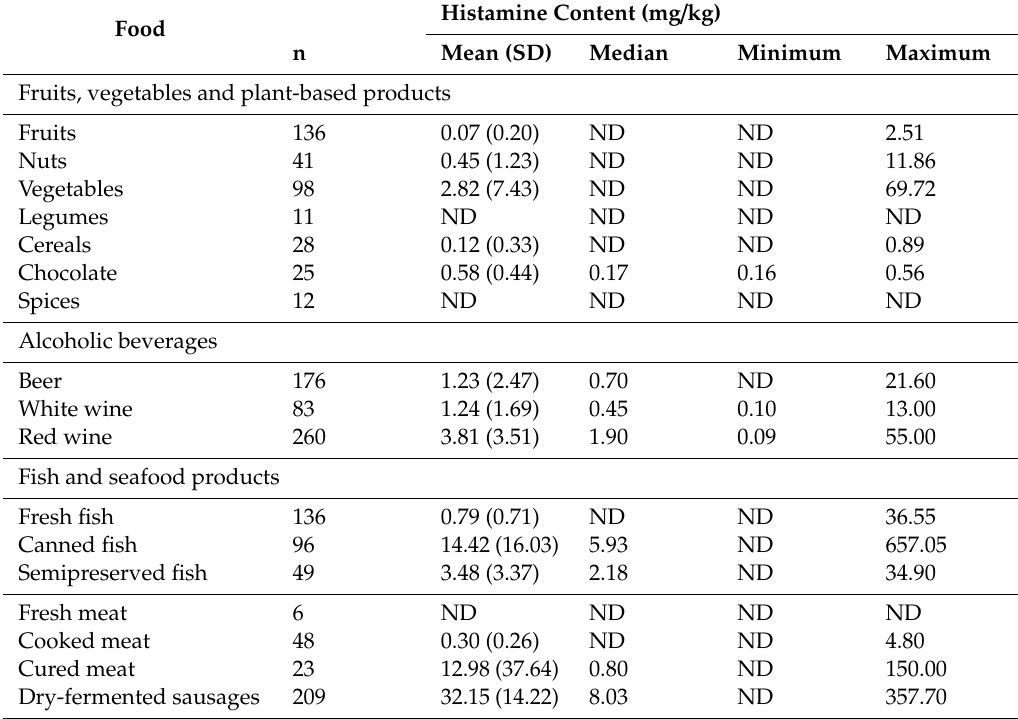
Table 1. Histamine content in di ff erent food categories. Adapted from